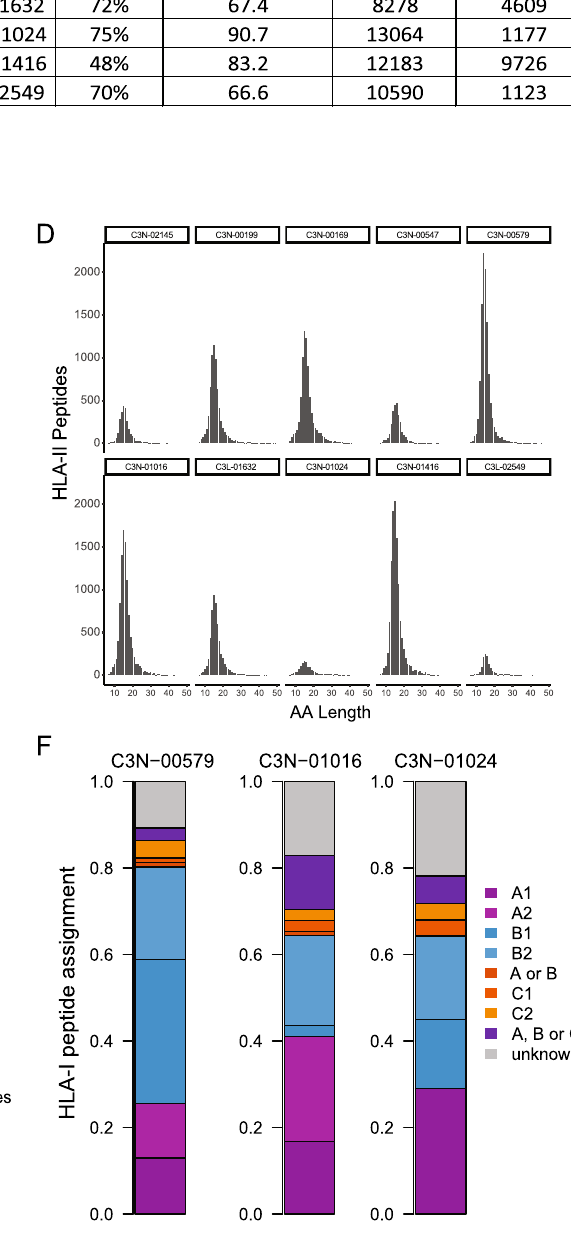
Fig. 3 | LUAD tumor HLA-I and HLA-II immunopeptidome pro fi ling using MONTE. A Schematic overview of the head-to-head serial multi-omic enrichment vs. MONTE work fl ows used to characterize ten cryopulverized primary LUAD tumors. B Table summarizing the tumor input and resulting HLA-I and HLA-II peptides mapping to human source proteins detected from ten LUAD patients. C Length distributions of HLA-I peptides from the LUAD cohort. D Length